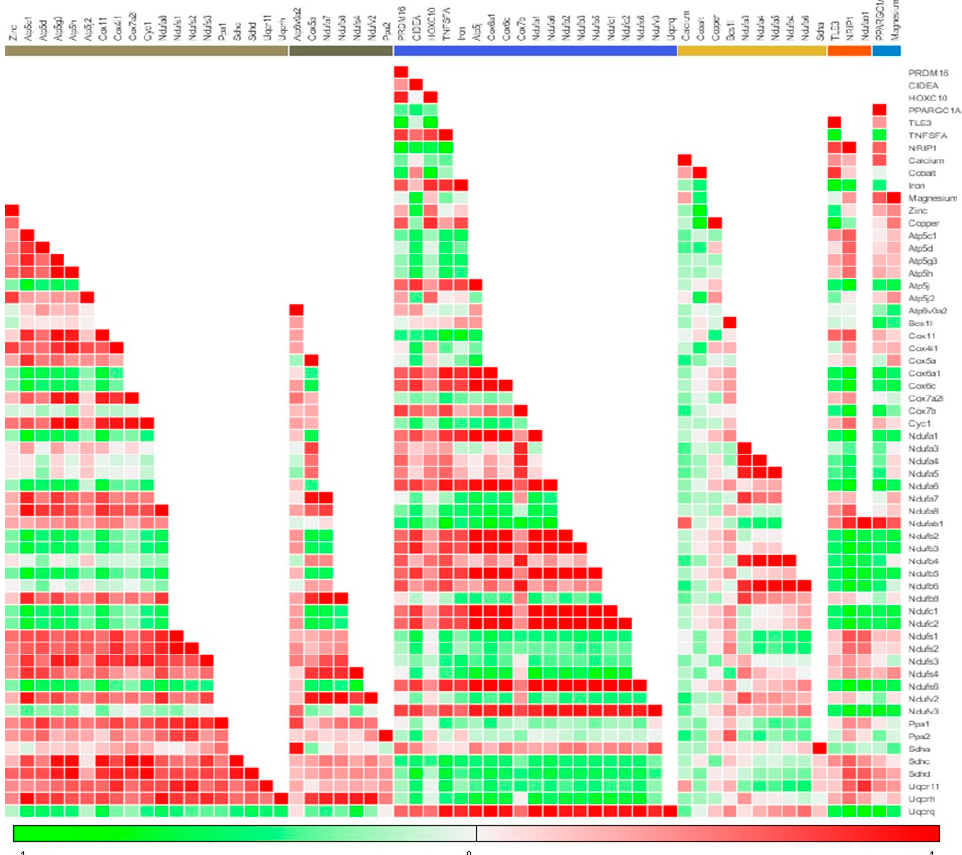
Figure 6. Correlation matrix and clustering of all the data generated through the experiments. The correlation matrix using K-means and Manhattan distance algorithms was drawn, which showed the clustered genes / parameters with respect to each other. Intensity of colours green and red indicate the negative or positive correlation respectively. Genes / parameters along X-axis are clustered using Manhattan distance plot, colour bars showing nearest related groups of genes/parameters.